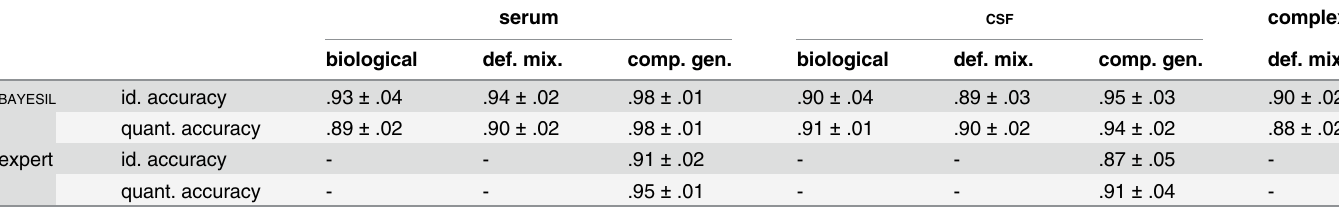
Table 1. Identification and quantification accuracy of Bayesil and human expert on various